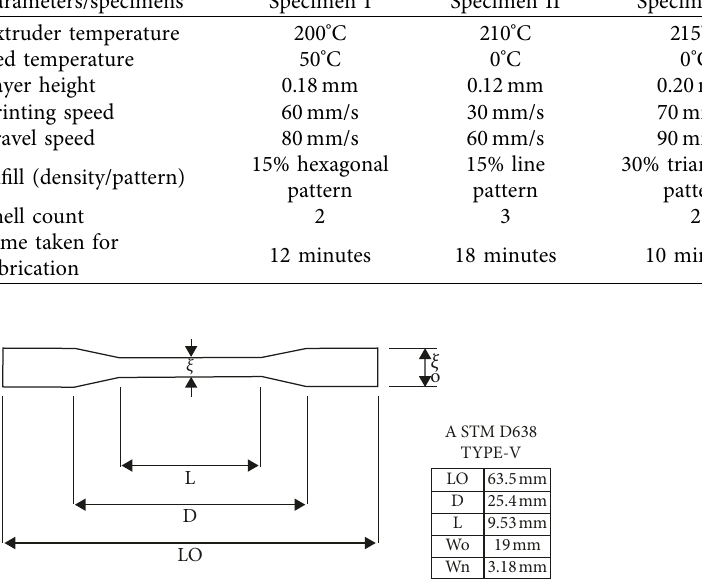
Figure 1: Geometrical parameters of tensile specimens.